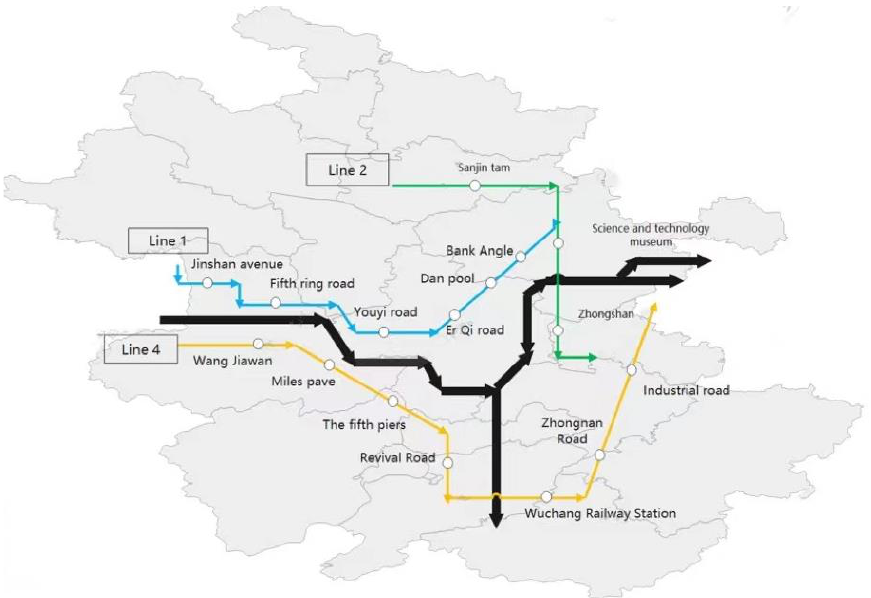
Figure 8. The subway line chart in